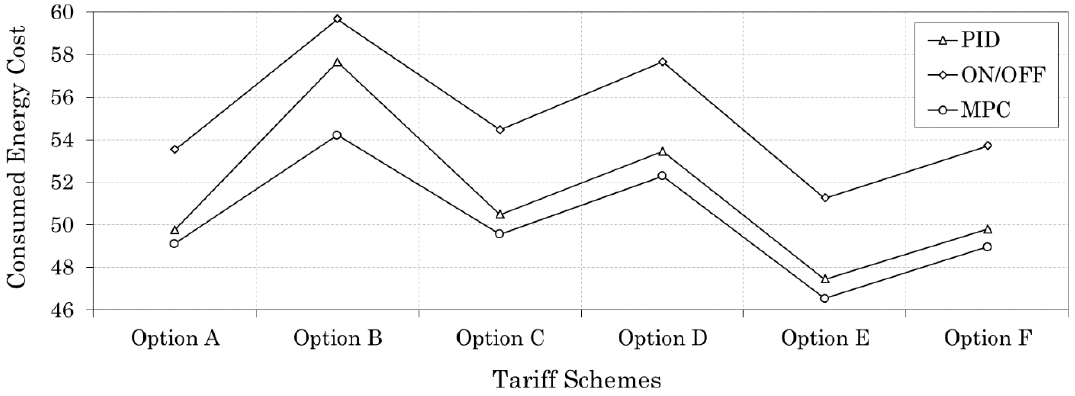
Figure 15. The cost of the consumed energy by ON/OFF, PID and MPC of the whole studied week. Appl. Sci. 2018 , 8 , x FOR PEER REVIEW